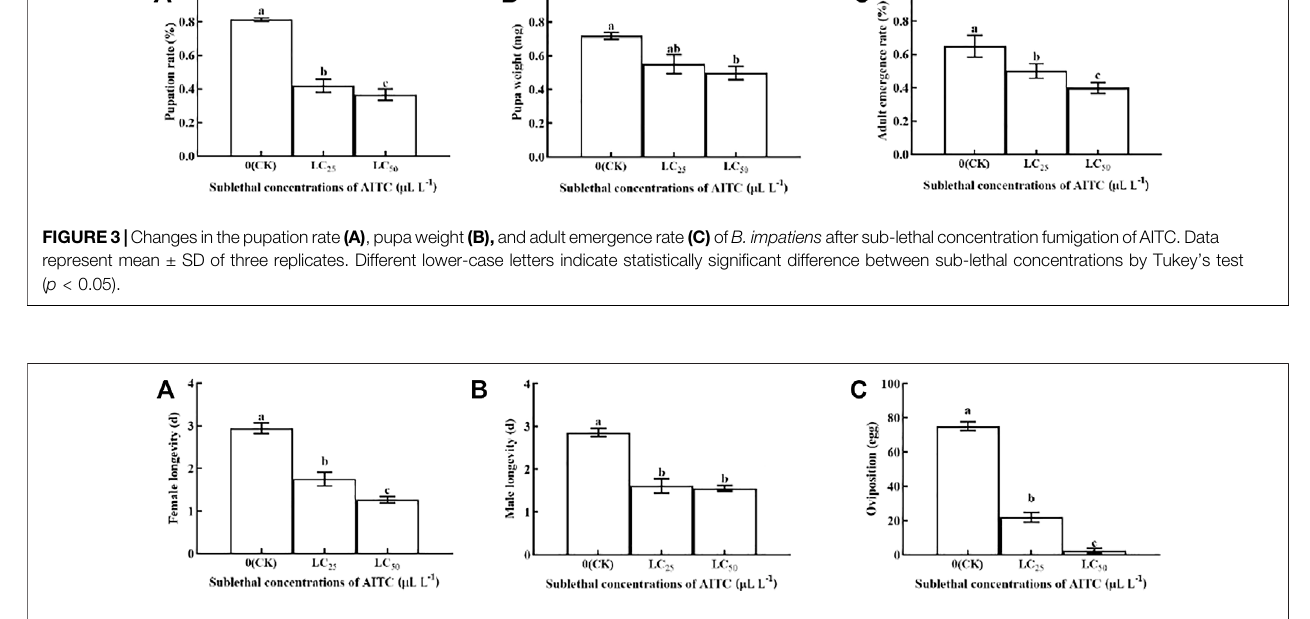
FIGURE 4 | Changes in female longevity (A) , male lingevity (B), and adult oviposition (C) of B. impatiens after sub-lethal concentration fumigation of AITC. Data represent mean ± SD of three replicates. Different lower-case letters indicate statistically signi fi cant difference between sub-lethal concentrations by Tukey ’ s test ( p <